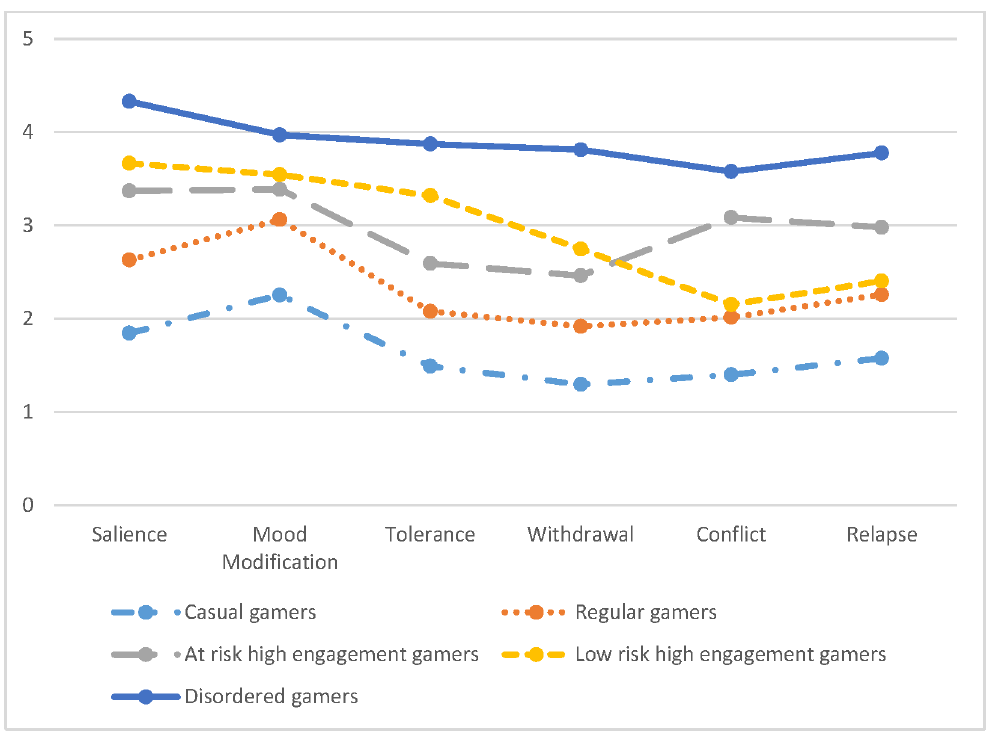
Figure 1. The Five Classes Obtained from the Latent Profile Analysis.